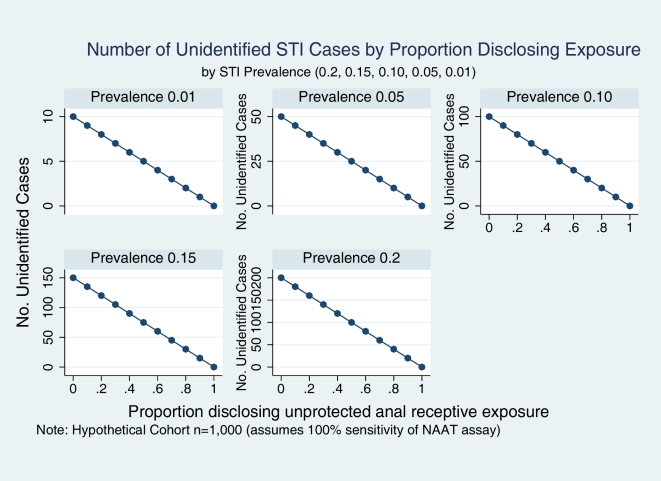
Model to estimate the number of unidentified cases based on a hypothetical cohort of 1000 patients, stratified by prevalence of asymptomatic STI (0.01, 0.05, 0.10, 0.20).Model assumes that those disclosing unprotected anal receptive exposure would all be screened with a NAAT assay having 100% sensitivity and specificity.